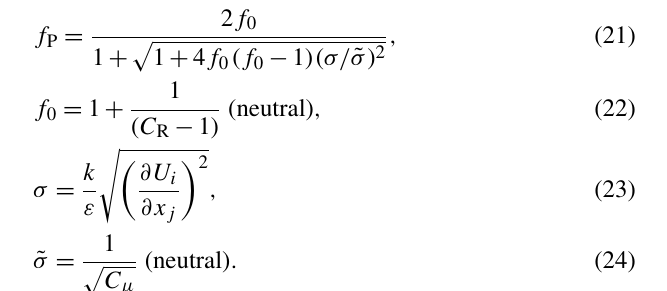
of B . Additionally, it can be noted that the cstB model has B / P ≈ 1 at z ref because ζ ref = − 0 . 5 was used (see Fig. 5.23 of Stull,